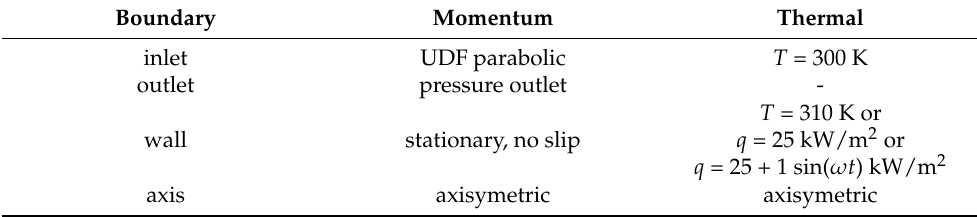
Table 1. Momentum and thermal boundary conditions for numerical calculations. The angular frequency was varied for different calculations. The results are presented for ω = 0.1047rad/s, corresponding to the period T = 60s (same as in the experiments). Boundary Momentum Thermal inlet UDF parabolic T = 300 K outlet pressure outlet - wall stationary, no slip axis axisymetric